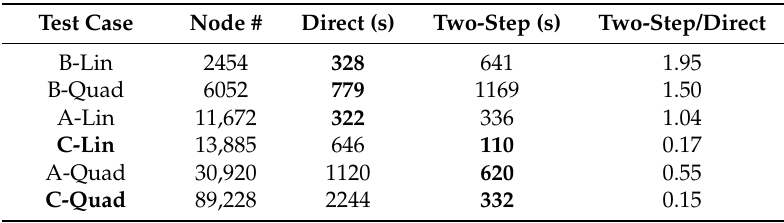
Table 5. Total calculation times for the proposed reduction techniques (Test Cases A, B and C).